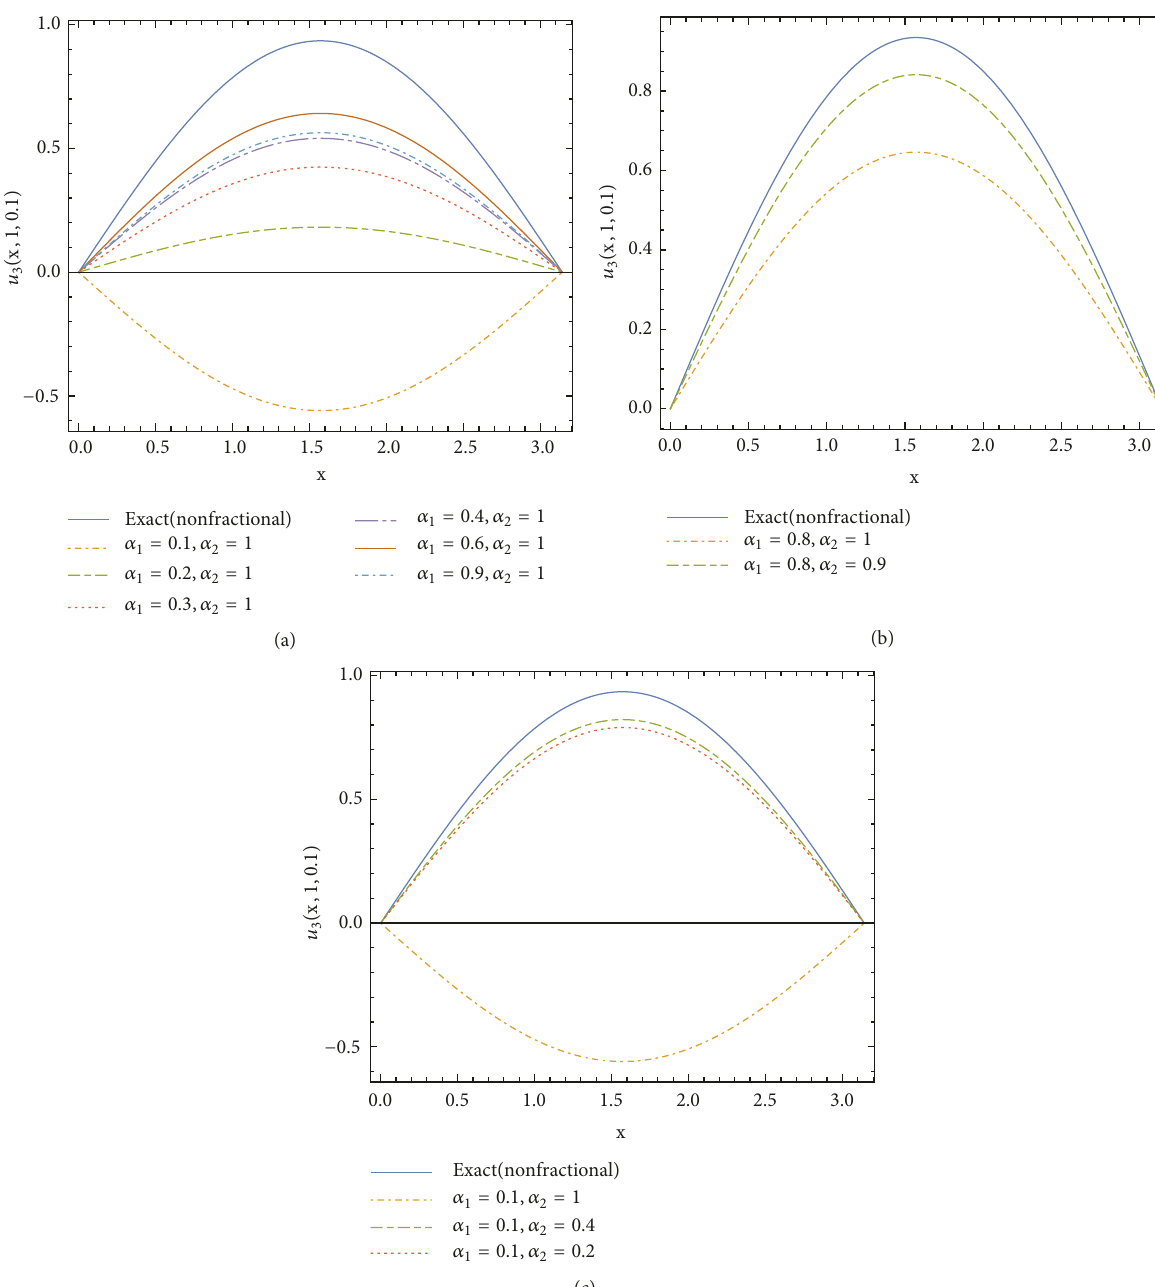
Figure 7: The 3-term FRDTM solutions 𝑢 3 . (a) constant 𝛼 2 = 1 and different values of 𝛼 1 , (b) constant 𝛼 1 = 0.8 and different values of 𝛼 2 , and (c) constant 𝛼 1 = 0.1 and different values of 𝛼 2 ; 𝑥 ∈ [0,𝜋] , 𝑦 = 1 ; and 𝑡 = 0.1